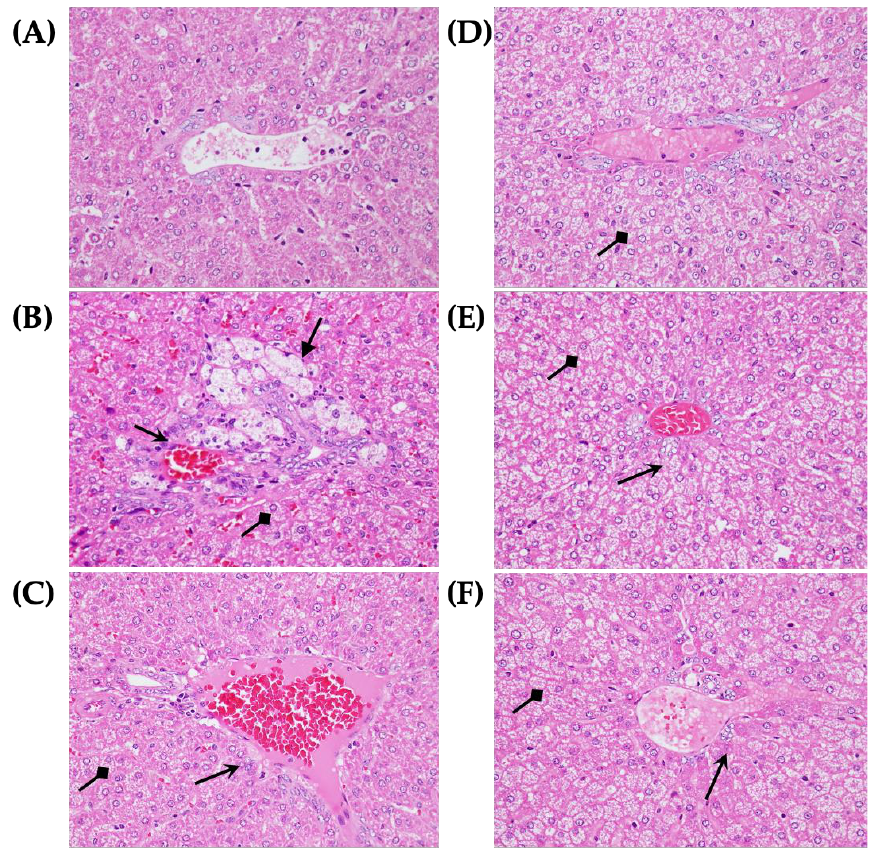
Figure 1. Pathological section images of the livers in high fat and cholesterol diet hamsters: ( A ) blank, ( B ) control, ( C ) SIM, ( D ) L-PME3-1, ( E ) M-PME3-1, and ( F ) H-PME3-1.